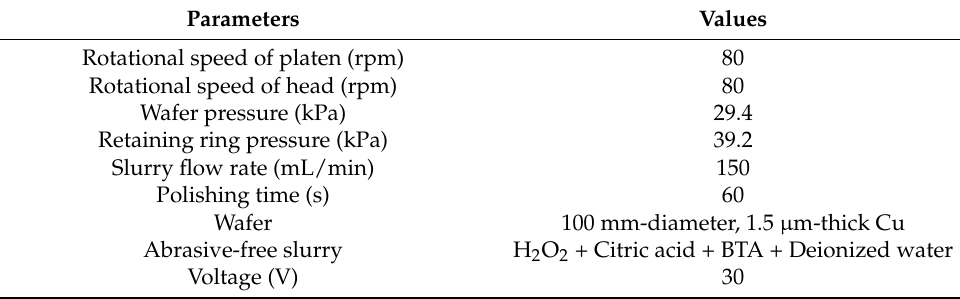
Table 1. Experimental